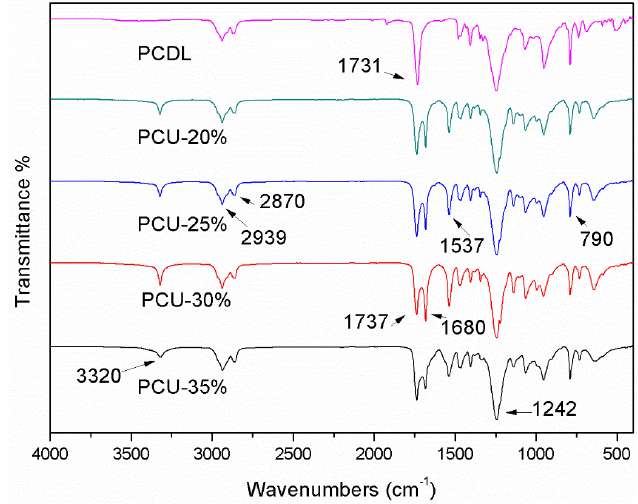
Figure 2. The FTIR spectra of poly(1,6-hexanediol)carbonate microdiols (PCDL) and the prepared polyurethane films.